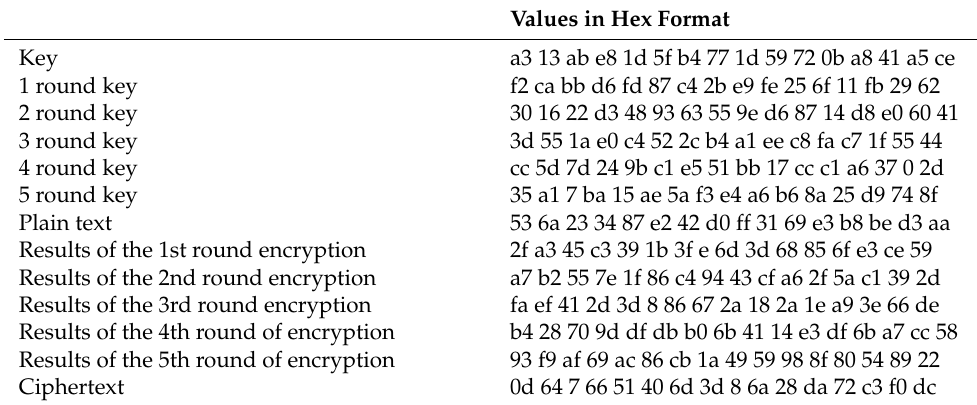
Table 4. Encryption example for the AL02 algorithm.